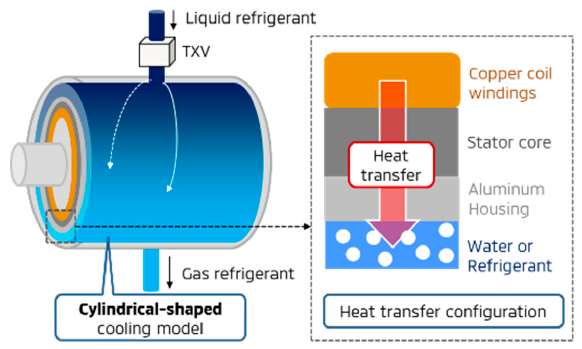
Figure 3. Simulation model. Table 2. Initial